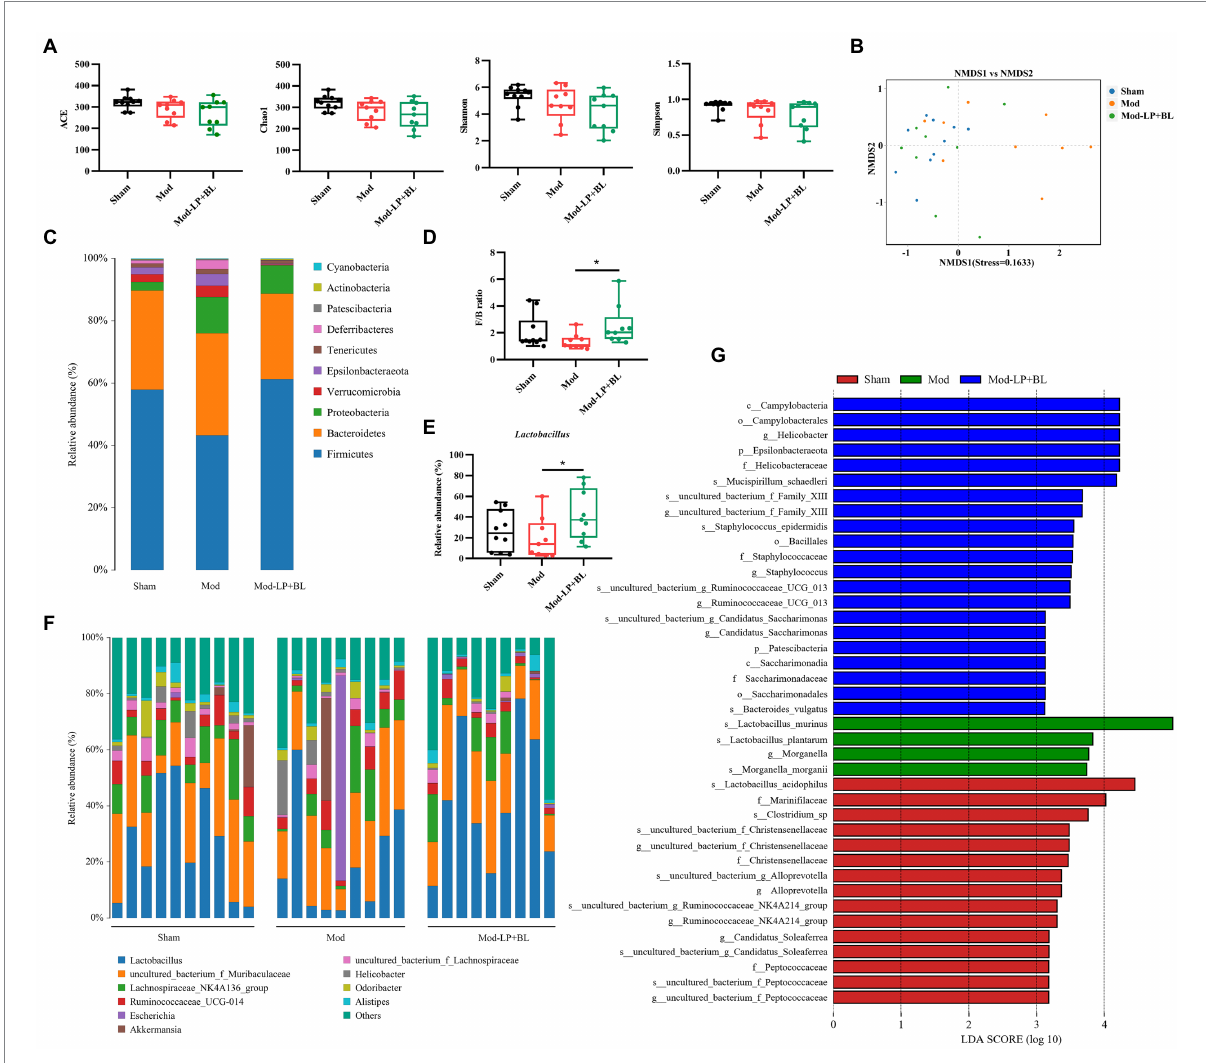
FIGURE 6 B. lactis combined with L. plantarum altered the gut microbiota composition in glioma mice. (A) Comparison of α -diversity of gut microbiota including ACE, Chao1, Simpson and Shannon index between the three groups. Wilcoxon rank-sum test. (B) NMDS analysis based on binary- jaccard distance, stress = 0.1633. Bar charts of the gut microbiota composition at the (C) phylum and (F) genus-level in the three groups. (D) F/B ratio, two-way ANOVA . (E) Relative abundance of Lactobacillus in the three groups, two-way ANOVA . (G) LDA score of enriched bacterial taxa, LDA > 3.0. Mod, Model. LDA, Linear discriminant analysis. LP, Lactobacillus plantarum ; BL, Bifidobacterium lactis . * p < 0.05. n =